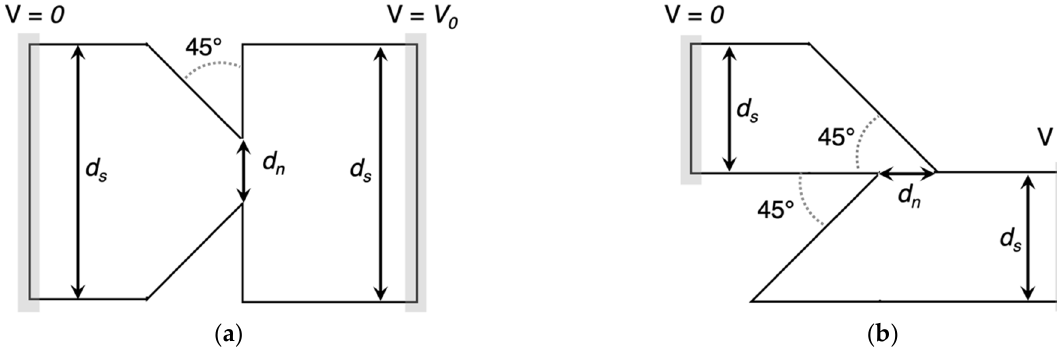
Figure 4. Relevant dimensions of ( a ) an inverse-arrowhead diode and ( b ) a Z-diode. The shoulder width is represented by d s , and the neck width is represented by d n . For electron carriers, the current, I , should be positive for a positive V 0 .